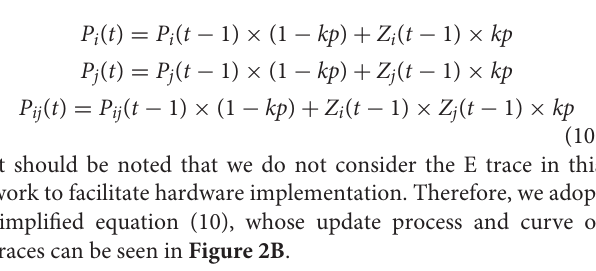
The current values of Z, E, and P traces are all calculated from their previous values. The kz i , kz j , ke and kp are all